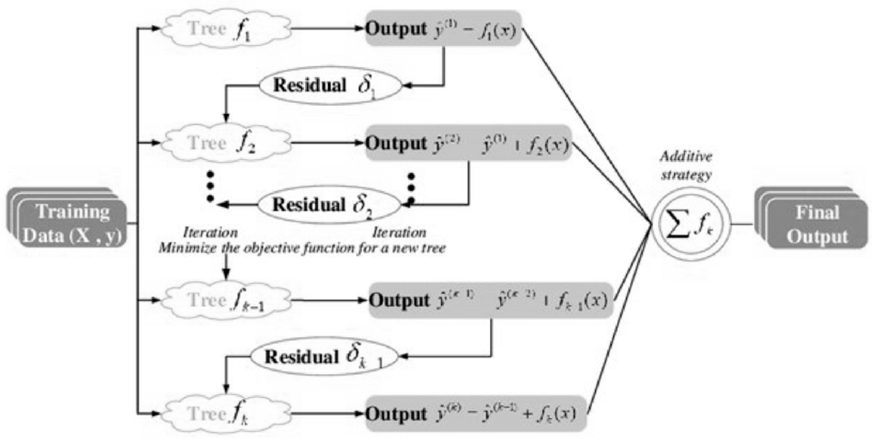
Figure 4. The concept of XGBoost, source: Cheng et al. [36].